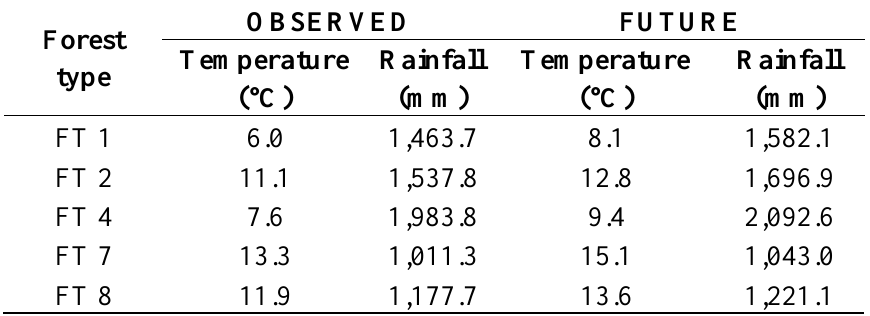
Table 2. Mean annual temperature and precipitation found over the five forest types examined for the present and future